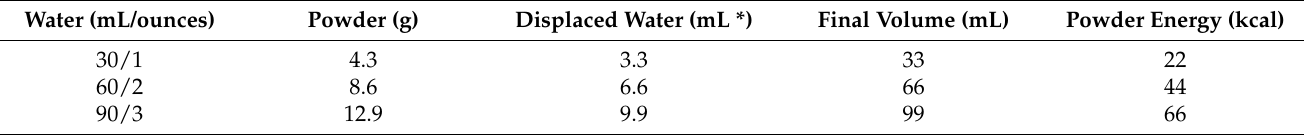
Table 5. Concentration and Final Volume of Properly Prepared Formulae. Modified from